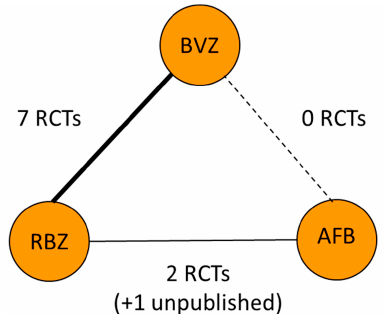
Figure 2. Node graph of the network meta-analytic model developed. Richness of the line means a number of studies available. Solid line—head-to-head RCTs are available. Dotted line means no head-to-head RCTs are available and an indirect comparison in the frame of the network meta-analysis is performed. J. Clin. Med. 2020 , 9 , x FOR PEER REVIEW